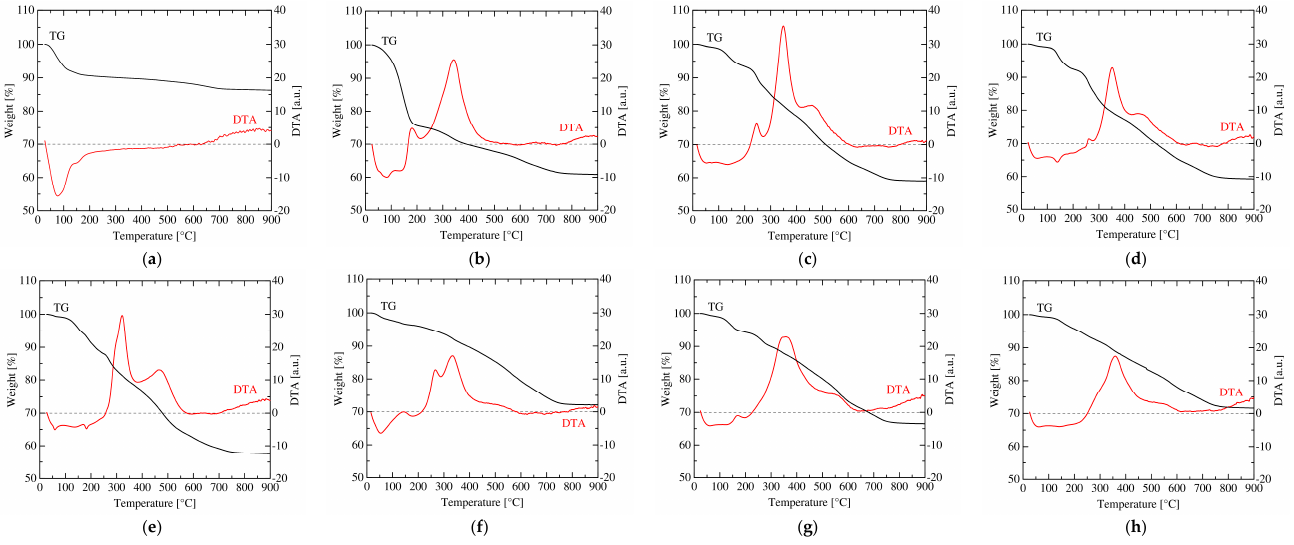
Figure 15. TG-DTA curves of ( a ) DA0 and DA5 samples ( b ) before adsorption and after adsorption of ( c ) MO, ( d ) CR, ( e ) EY, ( f ) MB, ( g ) CV and ( h ) RB (dosage = 0.5 g/L, initial concentration = 100 mg/L, temperature = 301